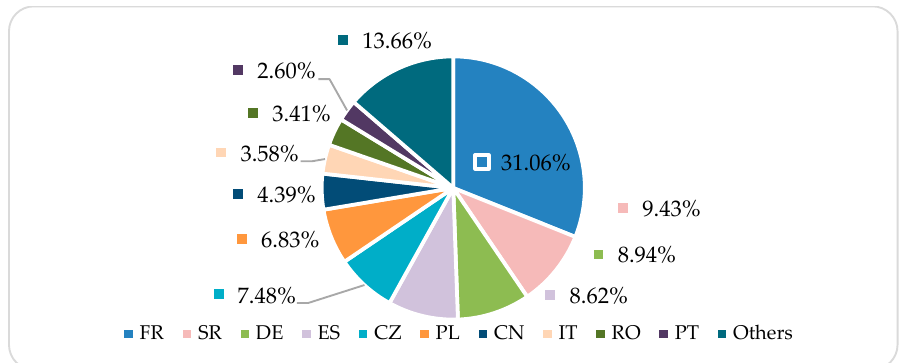
Figure 7. Percentage of value-added for C3 and 208 vehicles by country (2020–2021). Source: Authors’ compilation.